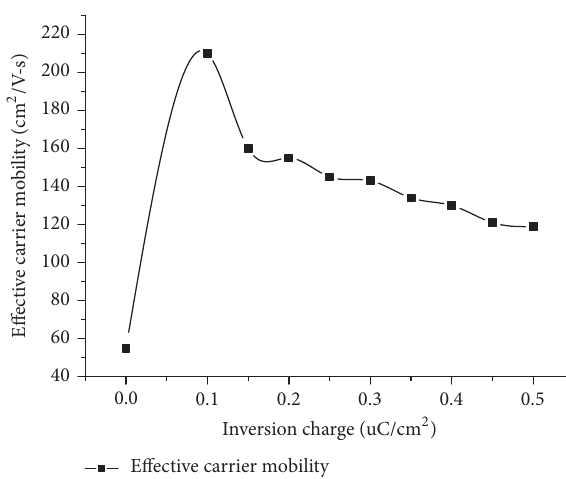
Figure 3: Evolution of permittivity with respect to annealing temperatures.